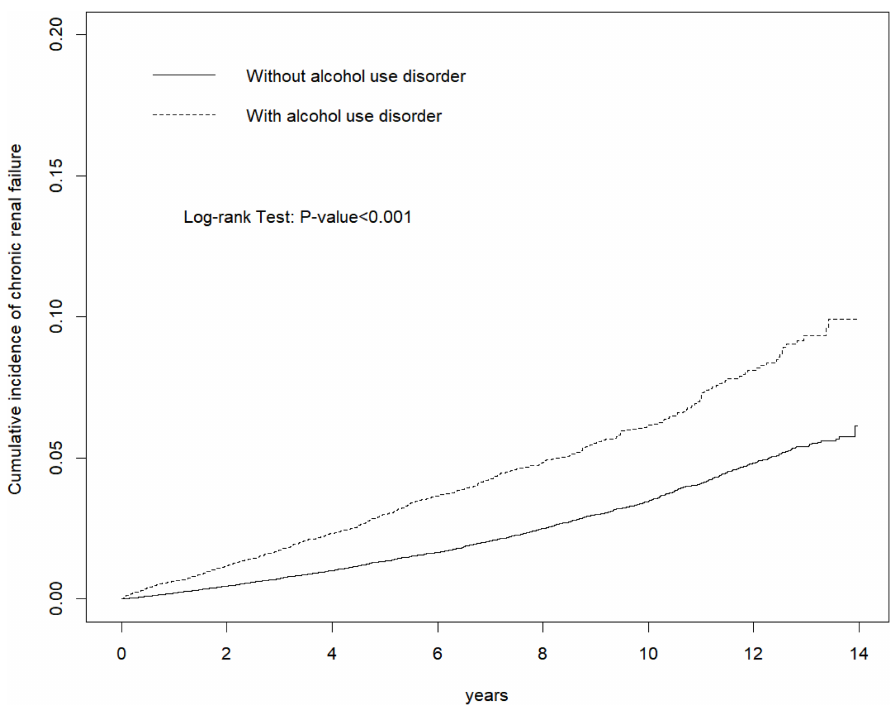
Fig 2. Cummulative incidence of chronic kidney disease in patients with alcohol use disorder and control cohort.